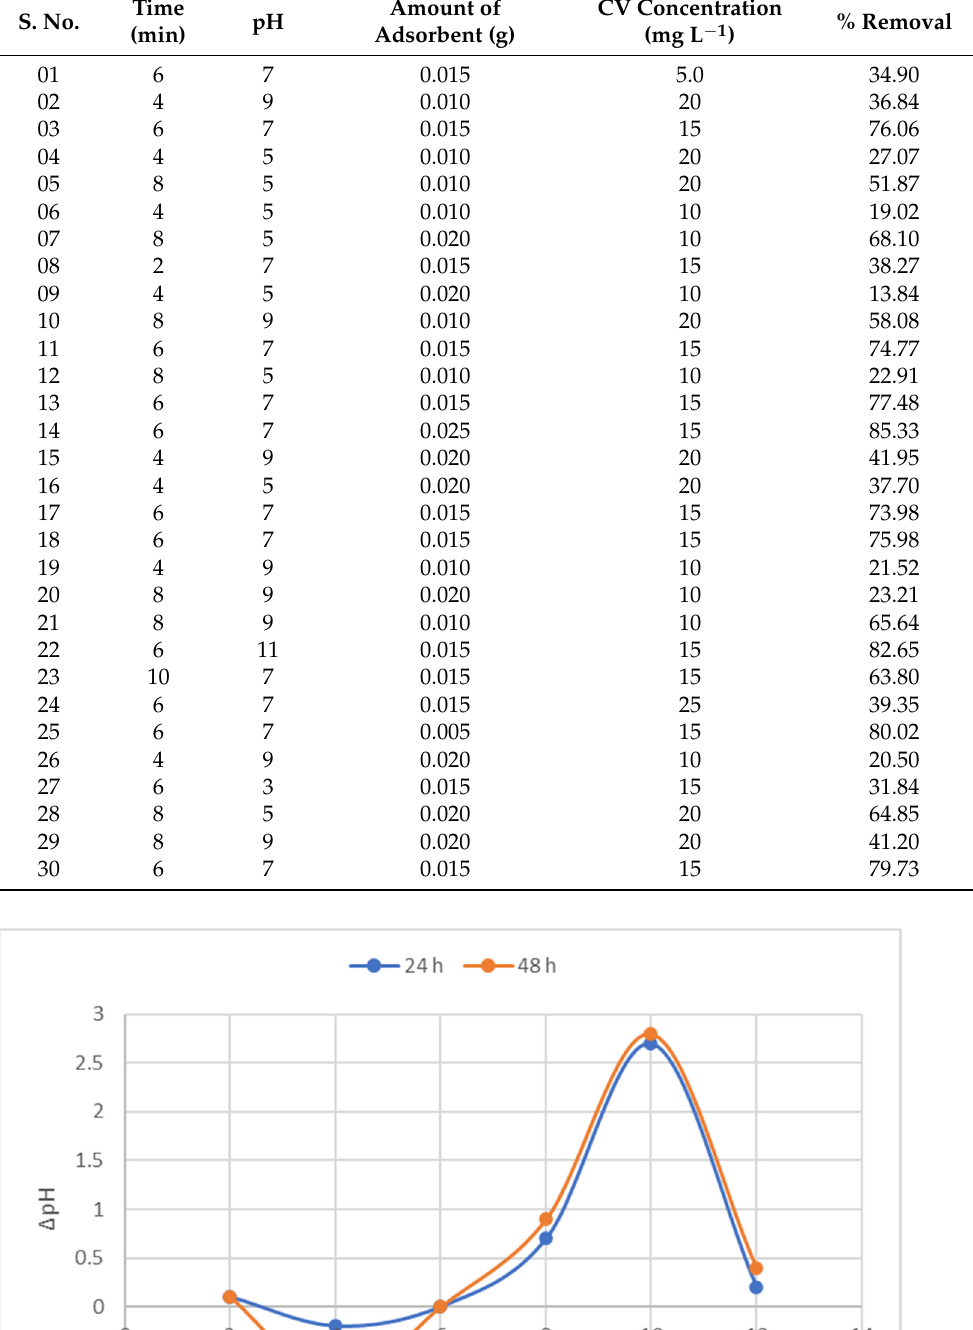
Table 1. Central composite design and the observed responses for the decontamination of CV from an aqueous medium.